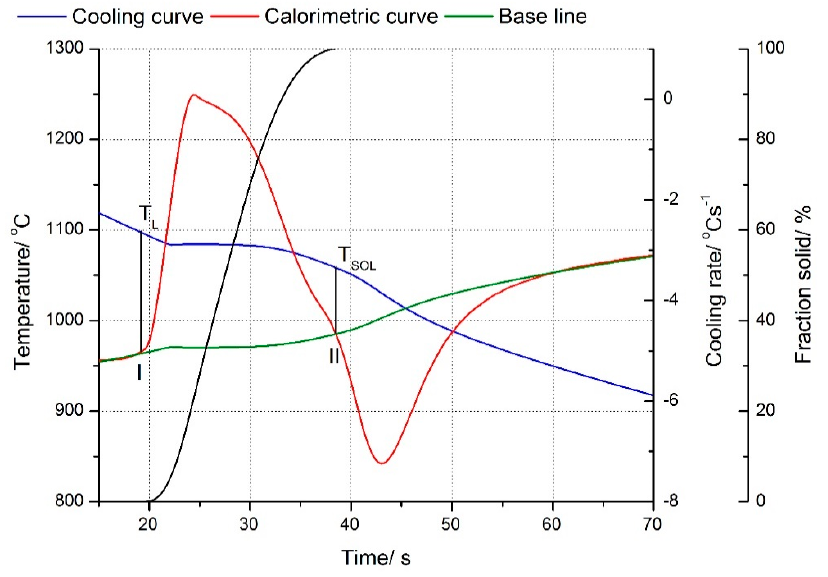
Figure 1. Cooling and derivative curves for Cu–2Ni–1Si alloys. Solid fraction during the crystallization of the particular compounds of Cu–2Ni–1Si alloy. Freely cooled alloy, cooling rate 2.2 °C s − 1 .